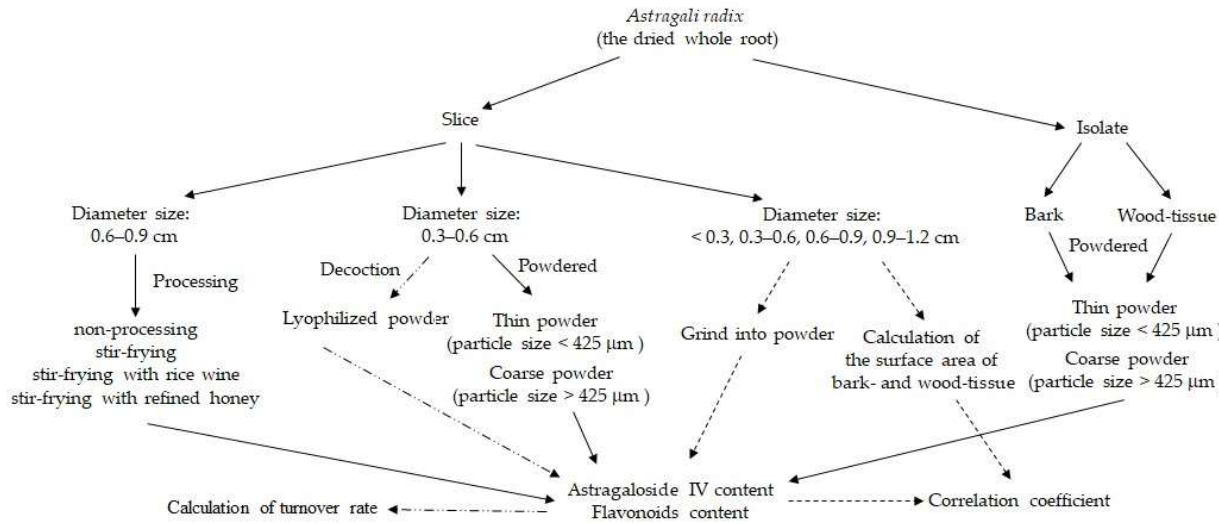
Figure 7. The overall preparation of diverse test